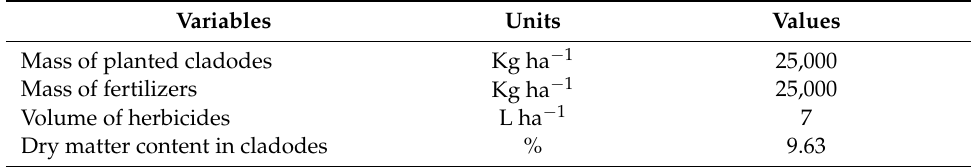
Table 6. Data for calculating E S and E FHP .